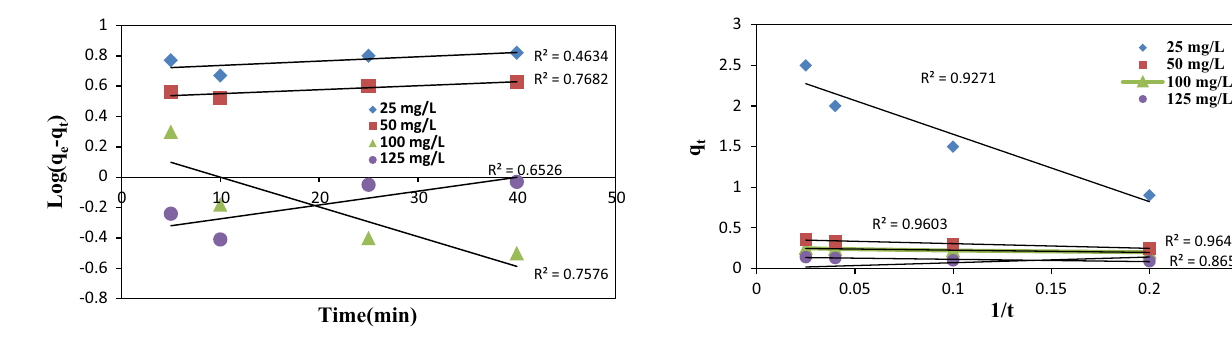
Fig. 6 Fitting of the Ho(II) linear model with the adsorption kinetic data